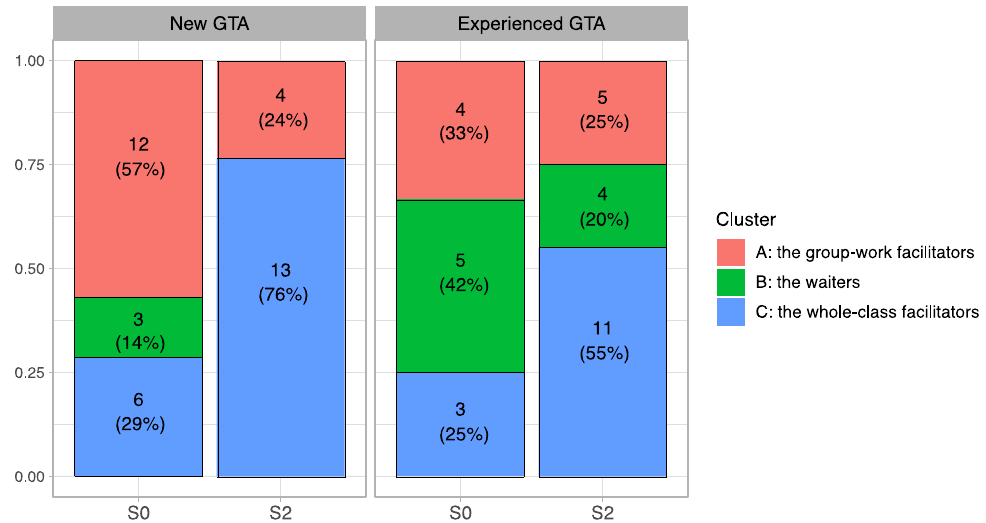
FIG. 8. The percentages of class periods observed in different clusters for GTAs with different teaching experiences. Compared to semester 0, both new and experienced GTAs in semester 2 used the group-work facilitator and the waiter less frequently, but more frequently used the whole-class facilitator. None of the new GTAs in semester 2 used the